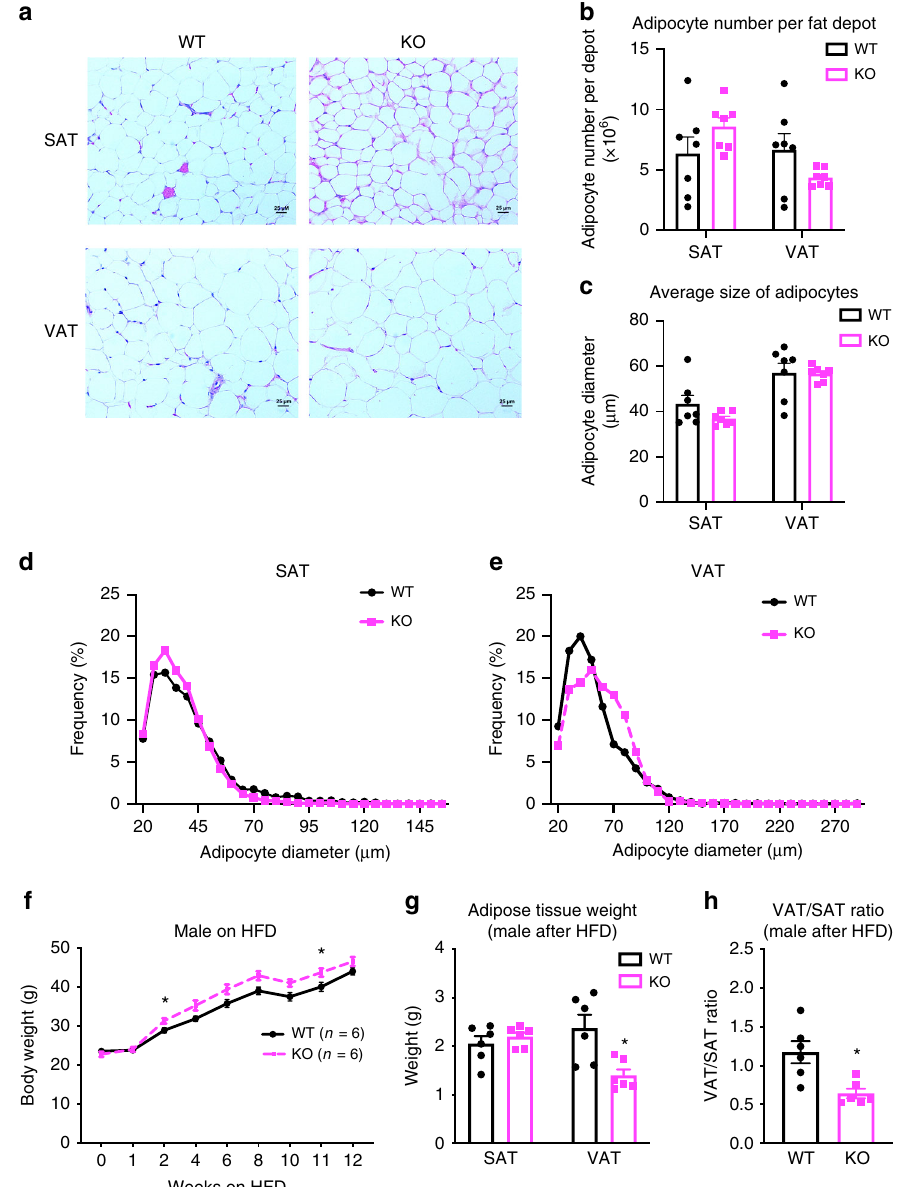
Fig. 4 Metabolic pro fi ling of male Fam13a KO mice. a Representative H&E images (×20 magni fi cation) of VAT and SAT in 14 weeks old of male WT and Fam13a KO mice fed on chow. ( n = 7 per group, ×20 magni fi cation, scale bar = 25 μ m). b , c Adipocyte number per SAT or VAT depot ( b ) and the average diameter of adipocytes in SAT or VAT ( c ), in 14-week-old male WT and Fam13a KO mice fed on chow. ( n = 7 per group). d , e Adipocytes size distribution in SAT ( d ) or VAT ( e ) of 14 weeks old of male WT and Fam13a KO mice fed on chow. ( n = 7 per group; 2000 – 2200 cells per animal were used for adipocyte diameter determination; statistical differences between WT and KO mice in adipocyte diameter distribution curve were estimated by Kolmogorov-Smirnov test, ns for both SAT and VAT). f Body weight of male WT and Fam13a KO mice fed on HFD from 8 weeks to 20 weeks old. ( n = 6 per group). g Tissue mass of male WT and Fam13a KO mice after 14 weeks HFD. ( n = 6 per group). h Ratio of VAT/SAT, based on tissue mass, in male WT and Fam13a KO mice after 14 weeks HFD. ( n = 6 per group). All values are presented as mean ± SEM. * p < 0.05, unpaired t -test. Source Data are provided as a Source Data fi